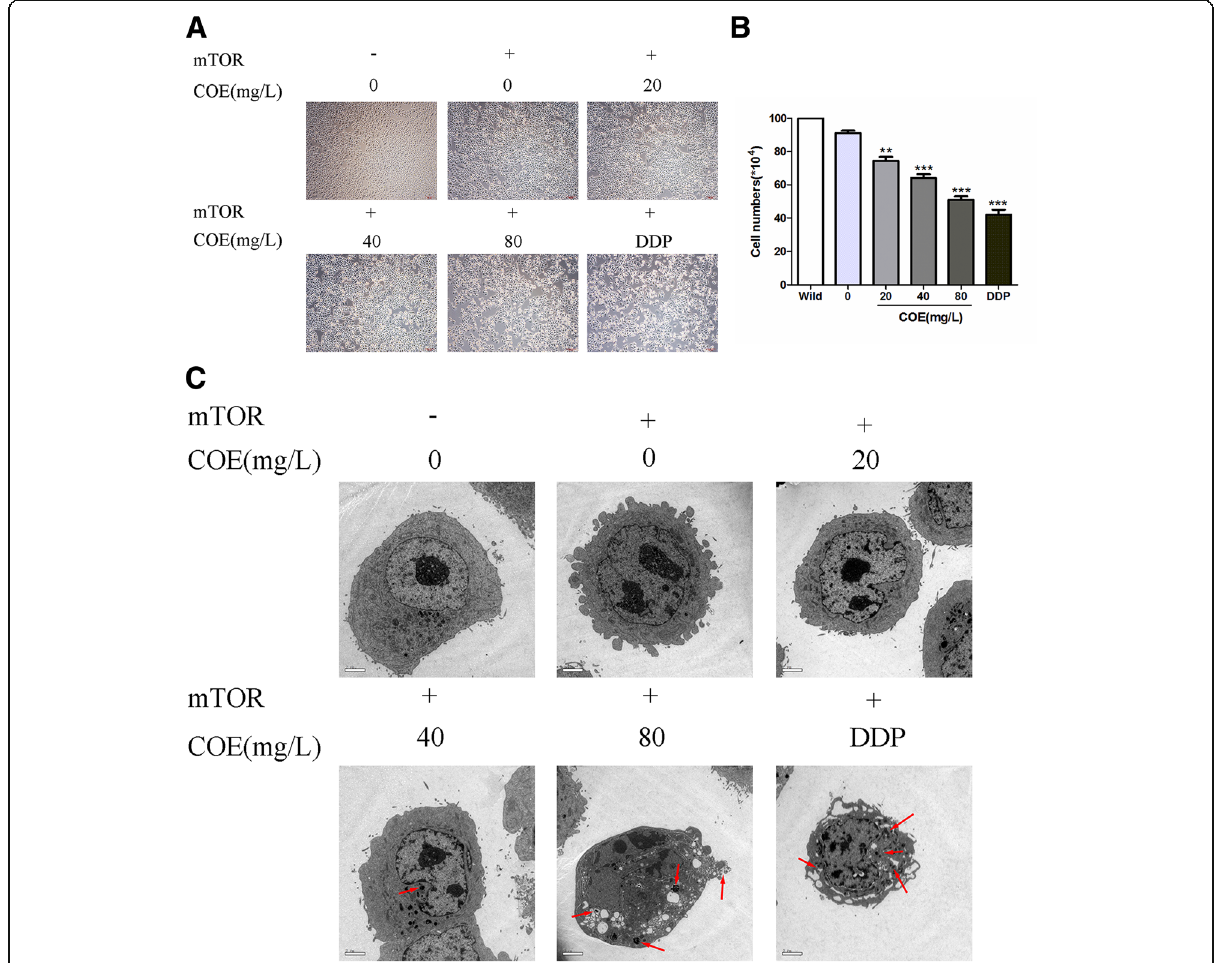
Fig. 3 Effects of COE on cellular morphology of the HCC cells. The HepG2/mTOR + cells were treated with 0.1%DMSO as solvent control, or 2 mg/ L DDP, or different concentrations of COE (20, 40, and 80 mg/L) for 24 h. a and b the HepG2/mTOR + cells were observed under inverted microscope and taken phase-contrast images from the same fields (100×). c the morphological changes were observed under transmission electron microscope (2950×, Scale, 1 μ m); red arrows are representative of the apoptotic bodies. ( ** P < 0.01, *** P < 0.001, compared with the